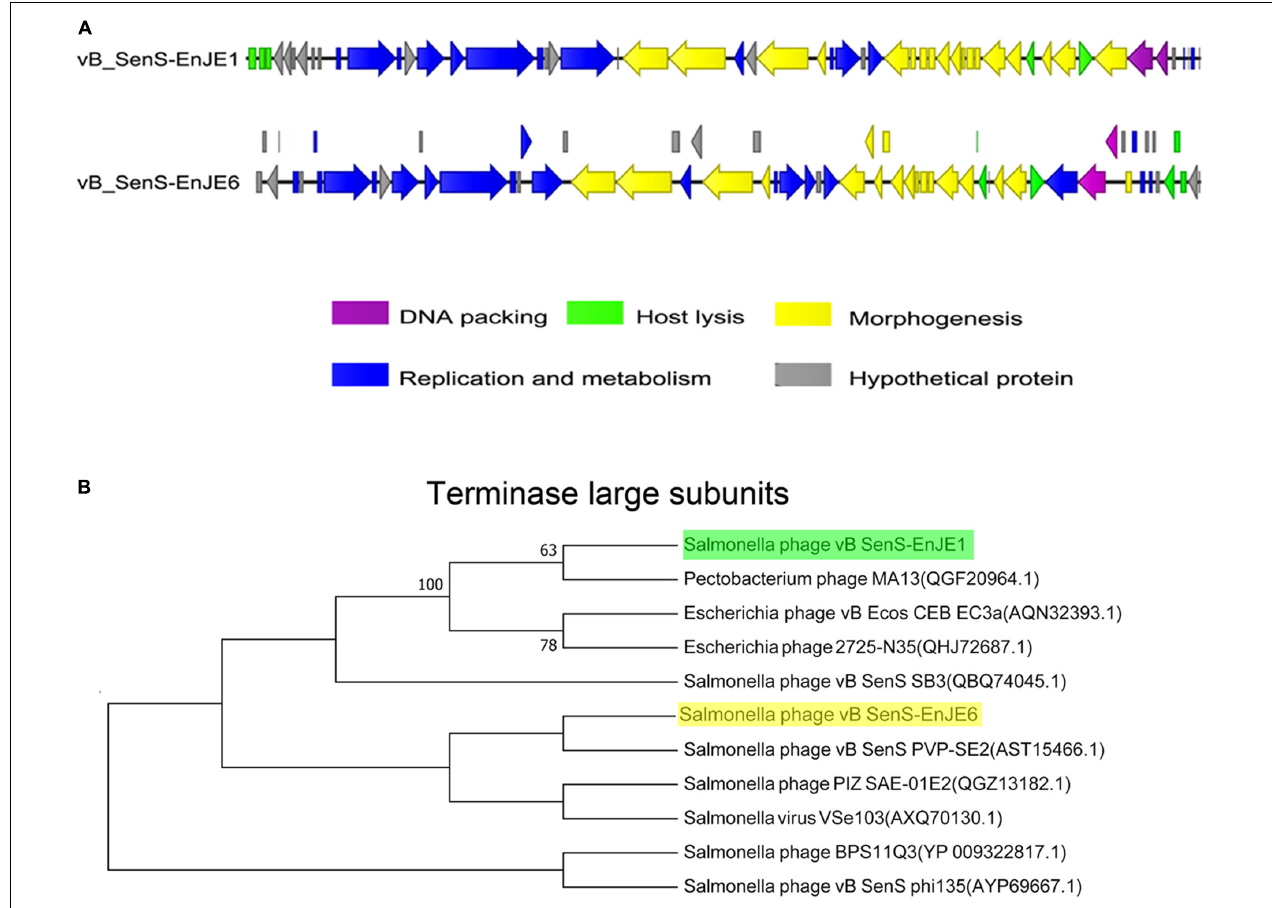
FIGURE 2 | Genome characterisation of phages. (A) Comparison analysis of the genomic organisation of vB_SenS-EnJE1 and vB_SenS-EnJE6. CLC workbench 8.1 was employed to visualise the putative CDSs and their transcript direction. The different colours represent different functional clusters. (B) Neighbour-joining tree of vB_SenS-EnJE1 and vB_SenS-EnJE6. The evolutionary relationship between isolated phages and reported phages was analysed based on the amino acid sequence of the terminal enzyme large